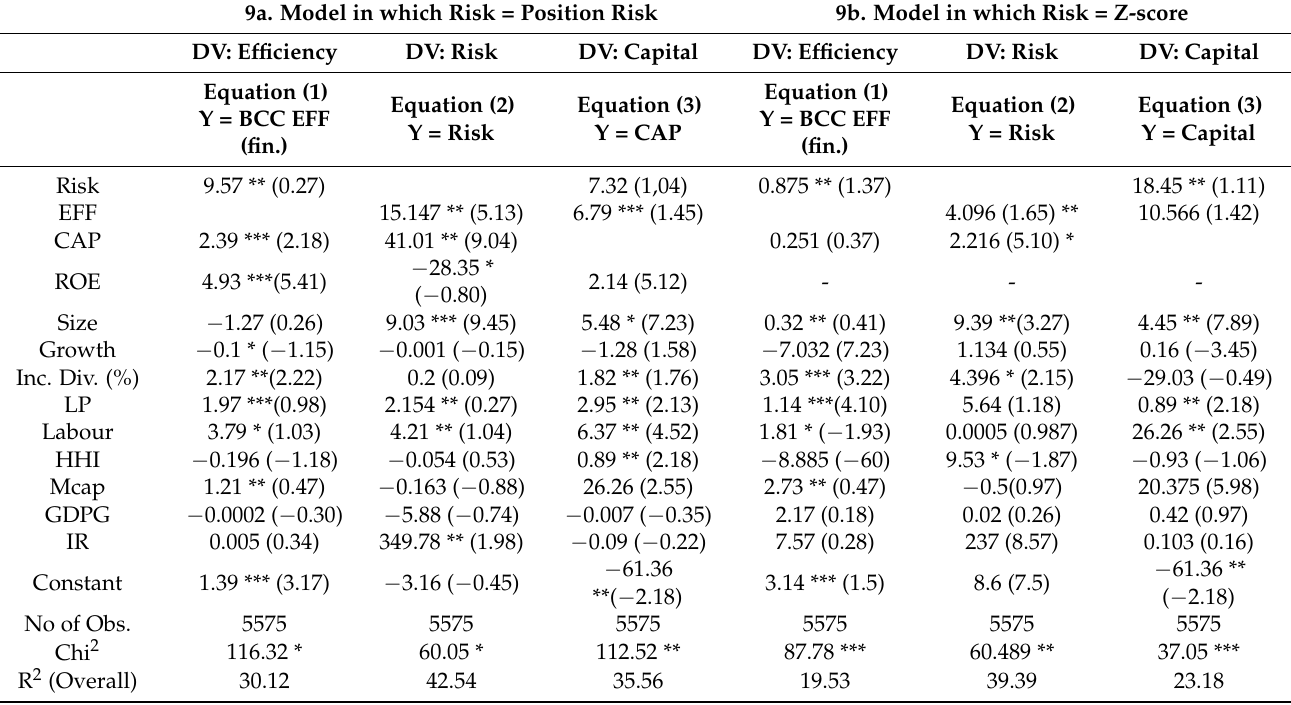
Table 9. Three-stage least-squares estimation of the relationship between securities firms’ capital, risk, and financial